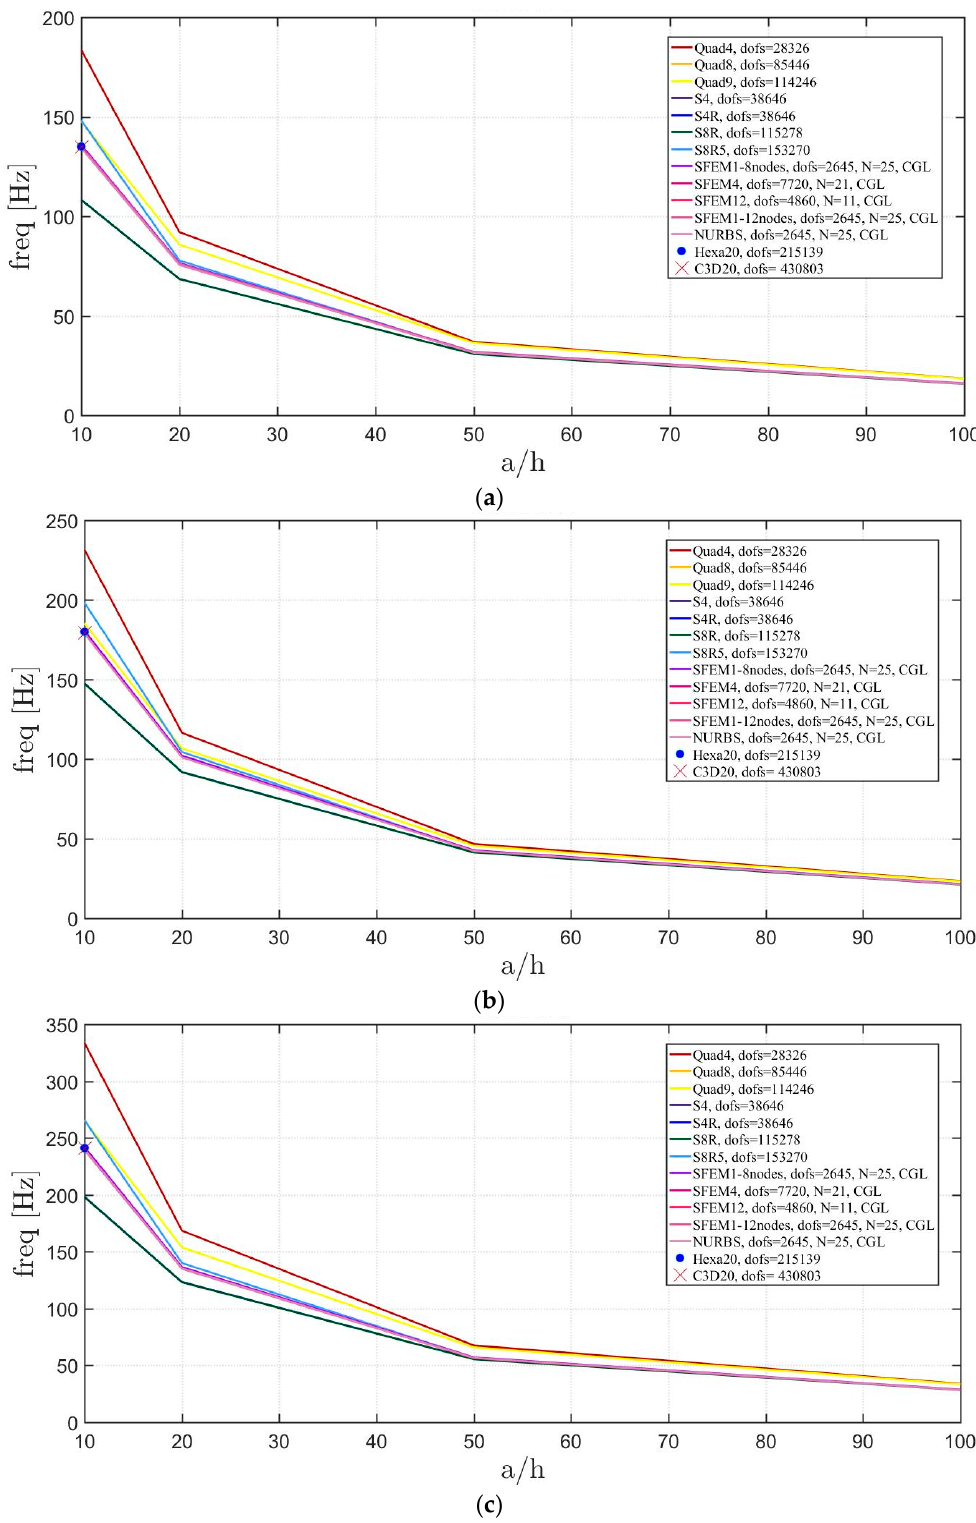
Figure 32. Thickness effect on the first three natural frequencies of an elliptic plate a / b = 1.5 with a not-symmetric lamination scheme: ( a ) First frequency; ( b ) Second frequency; ( c ) Third frequency.